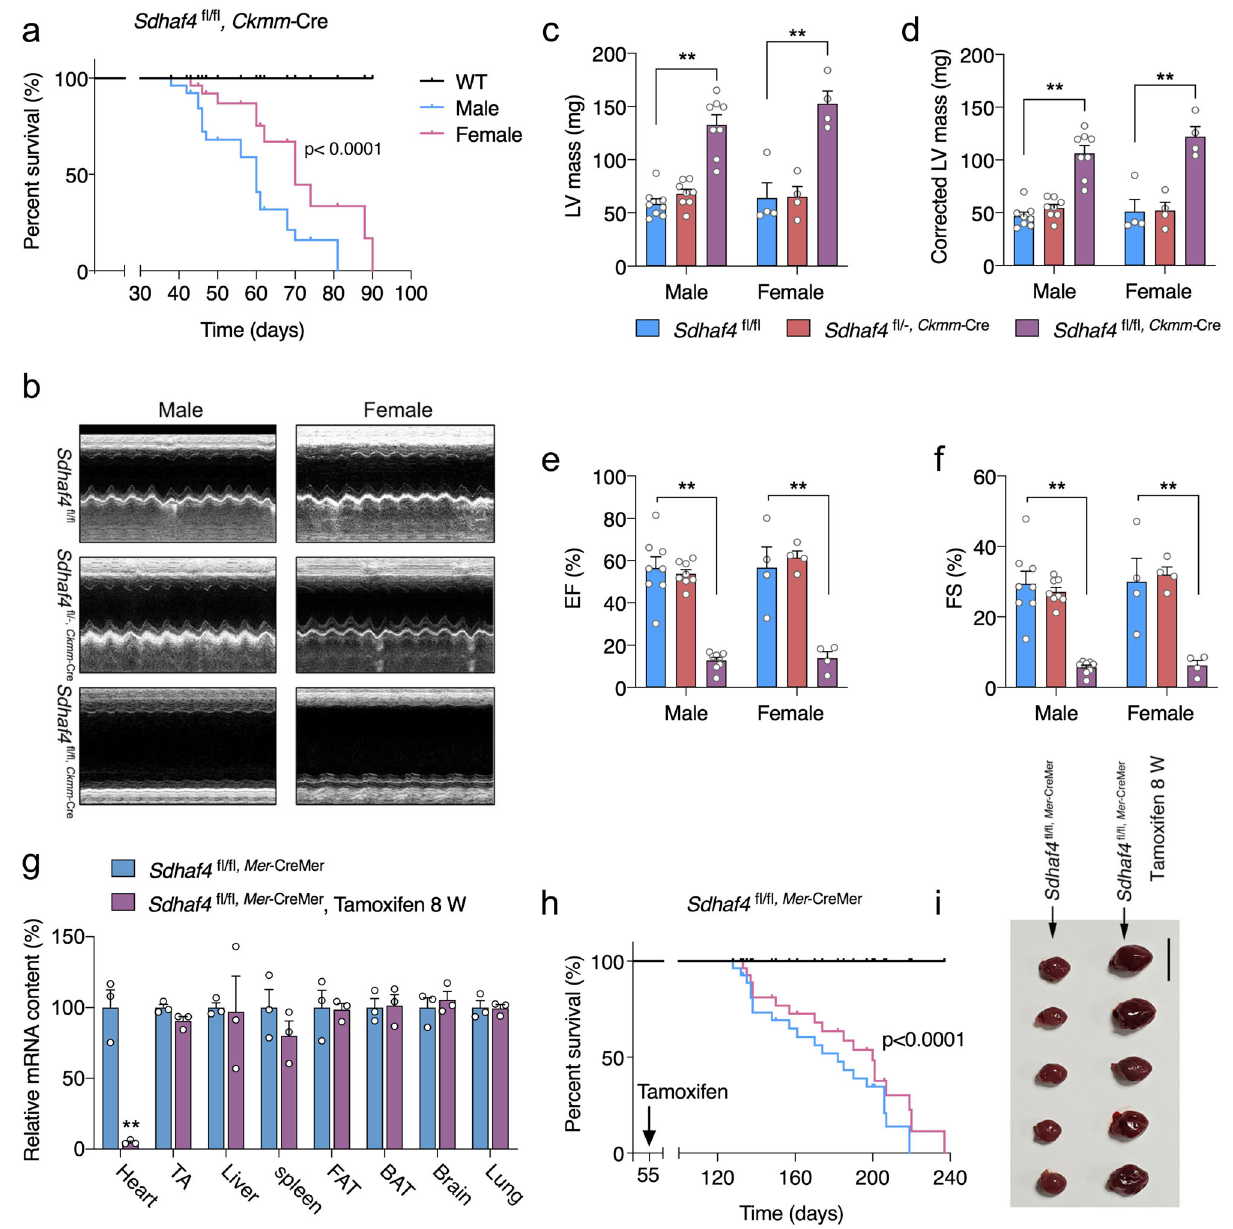
Fig. 2 Cardiac loss of SDHAF4 shortens mouse lifespan due to cardiac failure. a Postnatal survival curve for WT ( Sdhaf4 fl / fl , n = 15) and Sdhaf4 fl / fl , Ckmm -Cre mice (male, n = 20; female, n = 11). b – f Heart function measurements of WT, heterozygous ( Sdhaf4 fl /-, Ckmm -Cre ), and homozygous ( Sdhaf4 fl / fl , Ckmm -Cre ) mutant mice: representative M-mode echocardiography ( b ), left ventricular mass (LV mass, c , P <0.0001), corrected LV mass ( d , P <0.0001), percentage of ejection fraction (EF, e , P <0.0001), percentage of fractional shortening (FS, f , P <0.0001), n = 8 for male, n = 4 for female. g mRNA levels of Sdhaf4 in tissues of WT ( Sdhaf4 fl / fl , Mer -CreMer , n = 3, P <0.0001) and mutant mice ( Sdhaf4 fl / fl , Mer -CreMer after tamoxifen treatment for 8 weeks, n = 3). h Postnatal survival curve for WT ( n = 15) and cardiac Sdhaf 4 mutant mice (male, n = 21; female, n = 18). i Heart images of WT and cardiac KO mice, scale bar, 1cm. Values are mean±SEM, * P <0.05, ** P <0.01. Log-rank Mantel-Cox testing was performed for survival analysis ( a , h ), other statistical signi fi cance was determined by two- tailed Student ’ s t -test ( c – g ). Source data are provided in Source Data fi